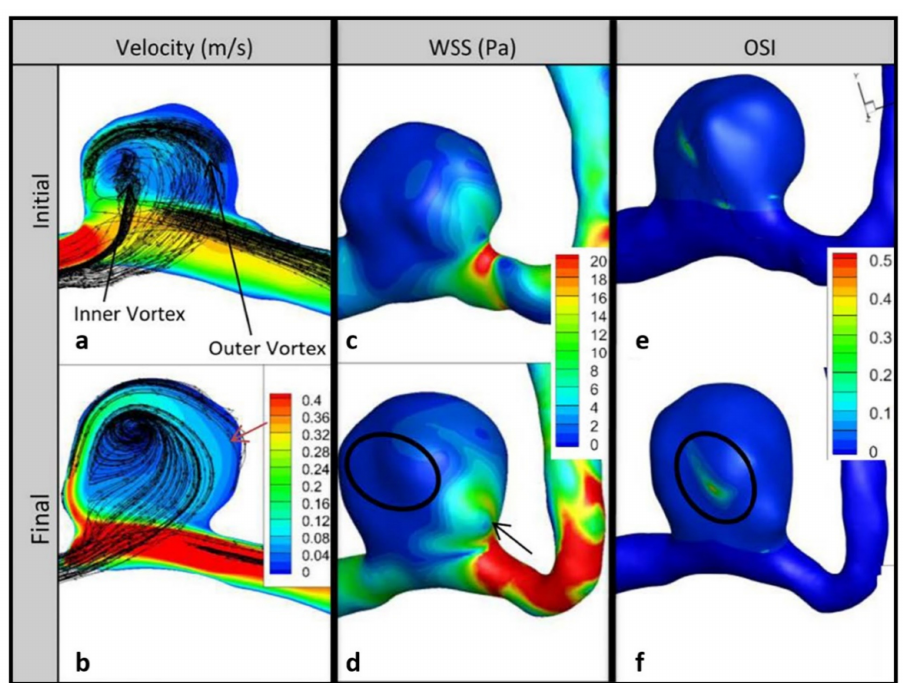
Figure 5. Impingement data planes and wall contours for P2. Velocity column shows changes in velocity between initial ( a ) and follow-up ( b ); red arrows show region of low velocity near higher velocity where growth occurred. WSS column shows changes in WSS between initial ( c ) and follow-up ( d ); black arrow shows change in WSS near the impingement region and circle shows low WSS near daughter bleb formation. OSI column shows changes in OSI between initial ( e ) and follow-up ( f ), circle shows increase in high OSI region.